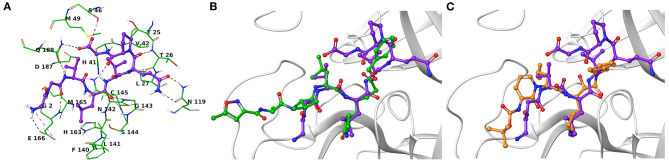
(A) Three-dimensional model of the AT1001-Mpro interactions. Superimposition of AT1001 with N3 (B) and 13b (C) into the catalytic site. The enzyme is represented by green tubes (A) and gray ribbons (B,C), and is colored for the following atoms: polar H, white; N, dark-blue; O, red; S, yellow. All ligands are depicted by sticks (purple for AT1001, green for N3, orange for 13b) and balls (colored by atom type: polar H, white; O, red). The C atoms of the ligands are colored as for the sticks. The black and pink dashed lines indicate hydrogen and ionic interactions, respectively.